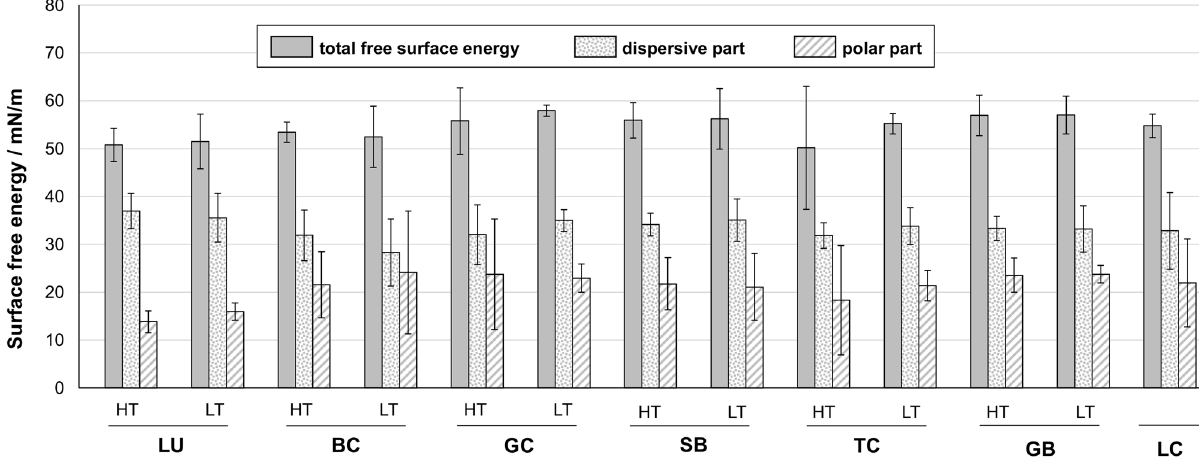
Fig. 2 Surface free energy (with standard deviations) and its polar/dispersive parts (according to the Owens/Wendt approach